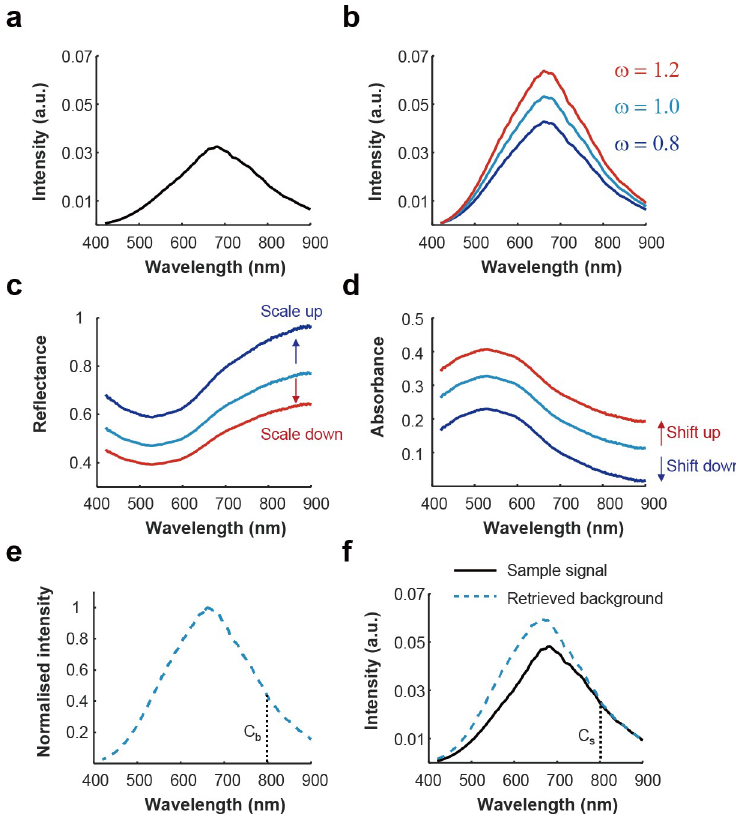
Fig 1. The effect of illumination power on absorbance and reflectance spectra. Raw spectra of 0.05 g/mL nigrosin dye (a) and the background halogen light source (b, ω = 1) were measured. To simulate the effects of the low and high illumination power, weighting factors ( ω = 0.8 and 1.2) were multiplied with the background spectrum. (c, d) Reflectance and absorbance were obtained for the three different weighting factors. Illumination power can be observed to change the scaling of reflectance spectra and the offset of absorbance spectra. (e, f) The proposed background retrieval method estimates the optical spectral power of the illumination at the sample by exploiting a normalised spectral profile of the light source (e) and the intensity ratio between the normalised spectral profile of the light source and sample data (C s /C b ) at a wavelength displaying low absorbance in the sample of interest, here selected as 800 nm (f)